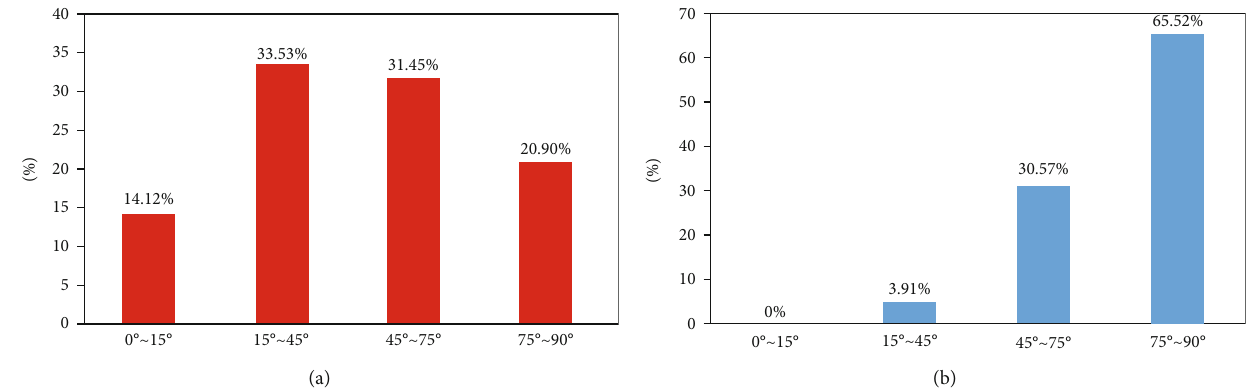
Figure 4: Distribution frequency diagram of shale fracture dip angle in the target layer, i.e., Longmaxi Formation (a) and Niutitang Formation (b), of southeastern Chongqing.